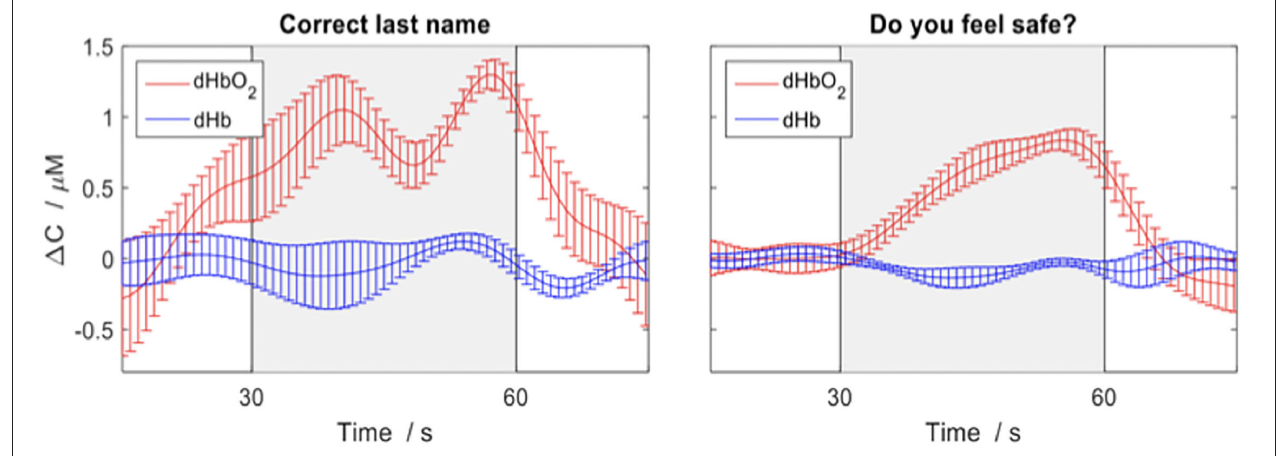
FIGURE 5 | Depicting the changes in concentration of oxygenated (red) and deoxygenated (blue) hemoglobin for various questions average across trials in a behaviorally unresponsive patient in ICU. The response period is indicated by the grey box and the error bars represent the standard error of the mean across channels. An increase in concentration of deoxygenated hemoglobin (red) indicates a yes response. Figure adapted and used with permission (